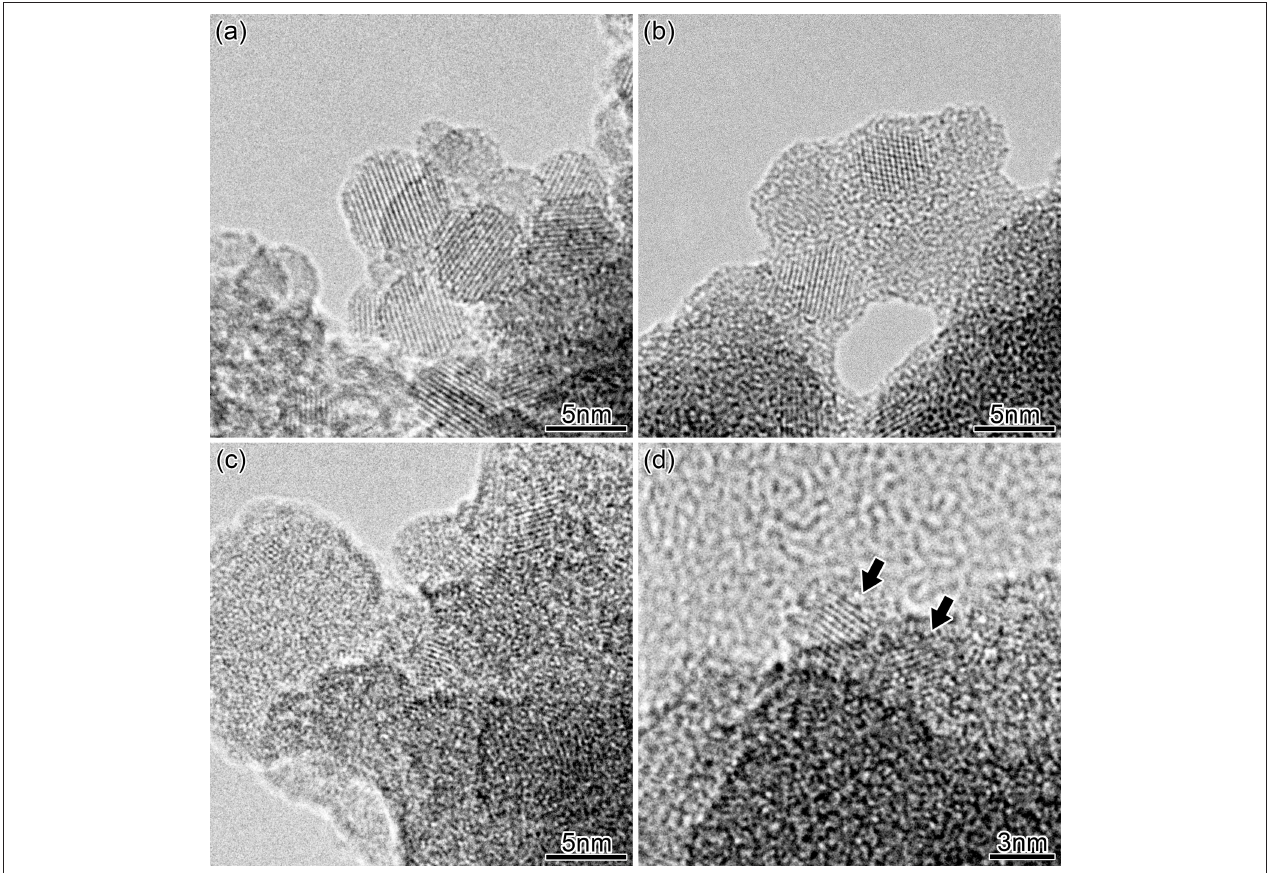
FIGURE 1 | TEM pictures of SiNCs before (a) and after HWA (b) . TEM pictures of PSi after HWA (c,d) . The arrows show the location of two